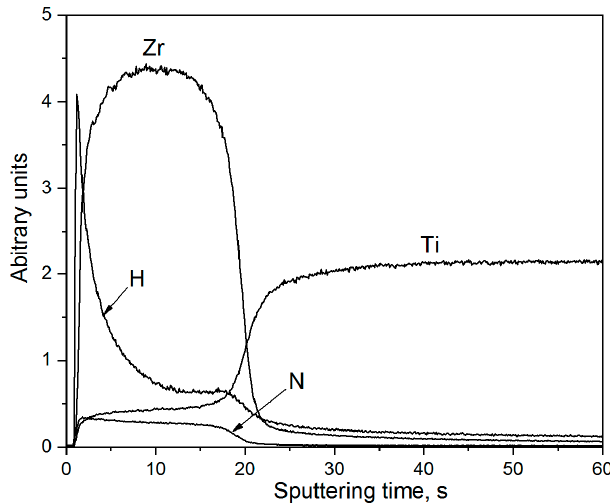
Figure 8. Element distribution profiles in the TZ2SMC specimens of the Ti0.16Pd with a δ —(Ti,Zr)N coating (ratio Zr/Ti = 1.28) after holding (430 h) at room temperature in air environment.